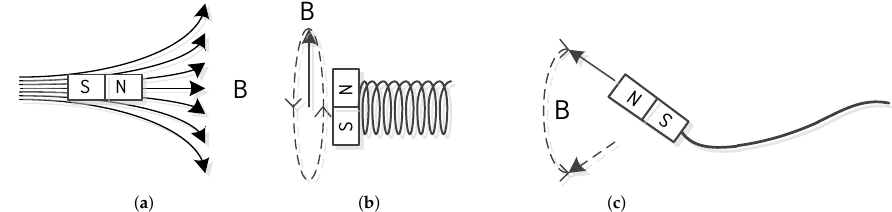
Figure 1. Schematic diagram of three types of magnetic field actuation methods. Their movement trends are all from right to left. ( a ) Compound magnetic field actuation; ( b ) Rotating magnetic field actuation; ( c ) Oscillating magnetic field